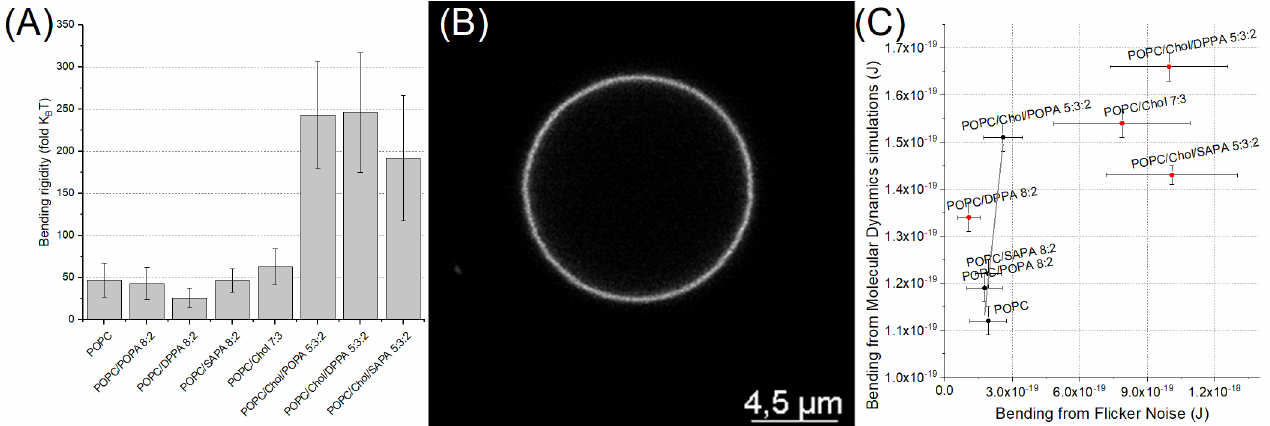
Figure 6. ( A ) Bending rigidity for investigated systems determined using statistical approach. ( B ) Example of recorded POPC/Chol/SAPA vesicle. ( C ) Correlation of bending rigidity values from flicker noise spectroscopy and molecular dynamic systems.